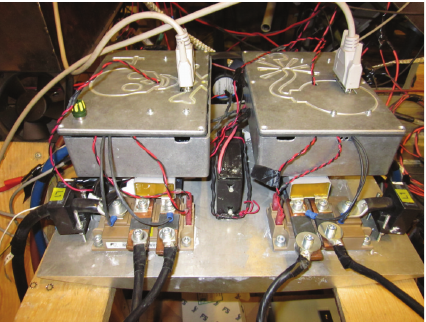
Figure 10: Two of the four H-bridge cells, with associated driver circuits mounted in the shielded boxes above the IGBTs.